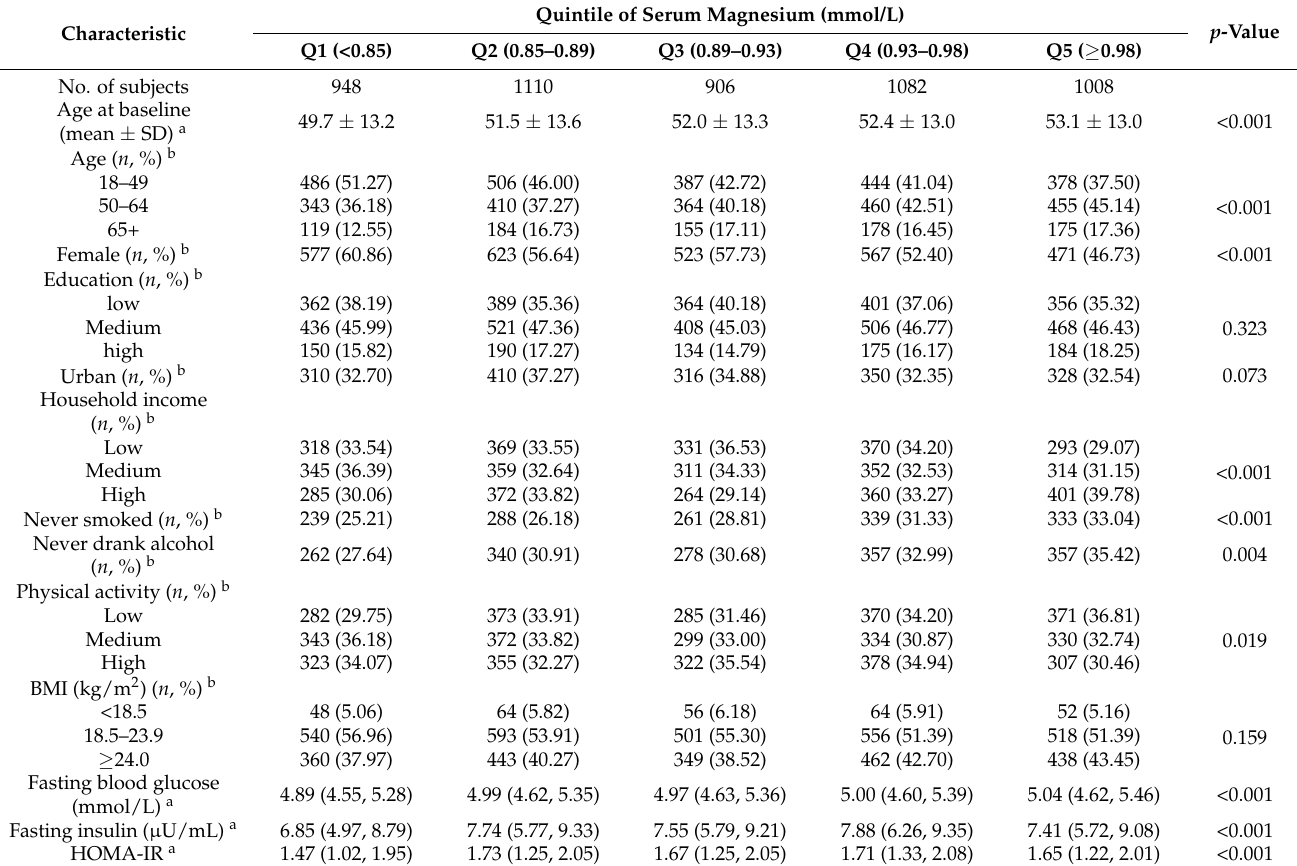
Table 1. Characteristics of participants by serum magnesium